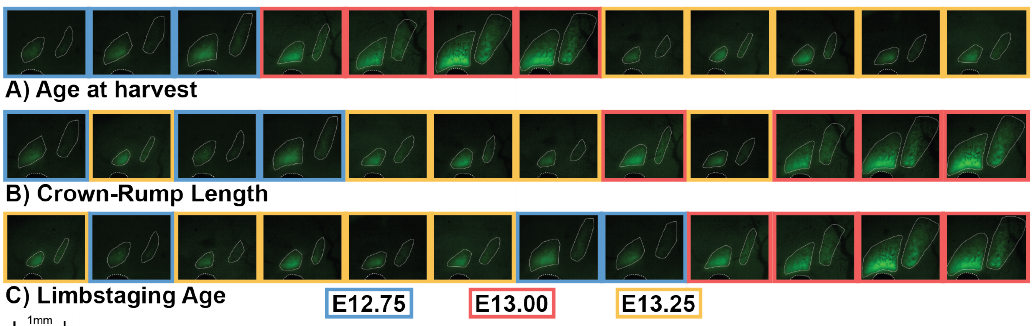
Figure 6. Appearance of frontal and parietal bones in Osx-GFP mice ordered by age at harvest, CRL, and limbstaging age. Each image shows a lateral view of the cranial vault of a left-facing Osx-GFP embryo, with Osx expression revealed by green fluorescent protein. The frontal and parietal bones and the eye are outlined in white to show the extent of Osx expression in each bone. The boxes outlining each specimen are colored according to age at harvest. Each age group is represented by a single litter. ( A ) specimens ordered according to age at harvest; ( B ) specimens ordered according to CRL; ( C ) specimens ordered according to limbstaging age.